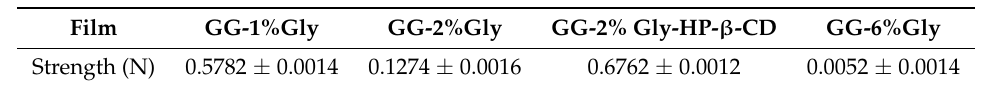
Table 1. Mucoadhesion strength